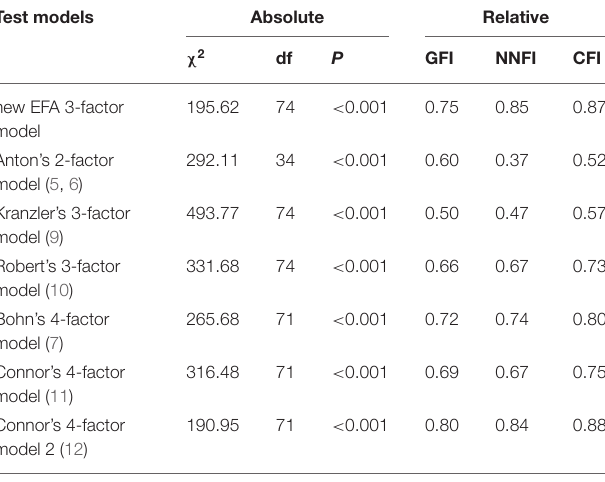
TABLE 3 | Measures of fit for different models of internal structure of OCDS. Test models